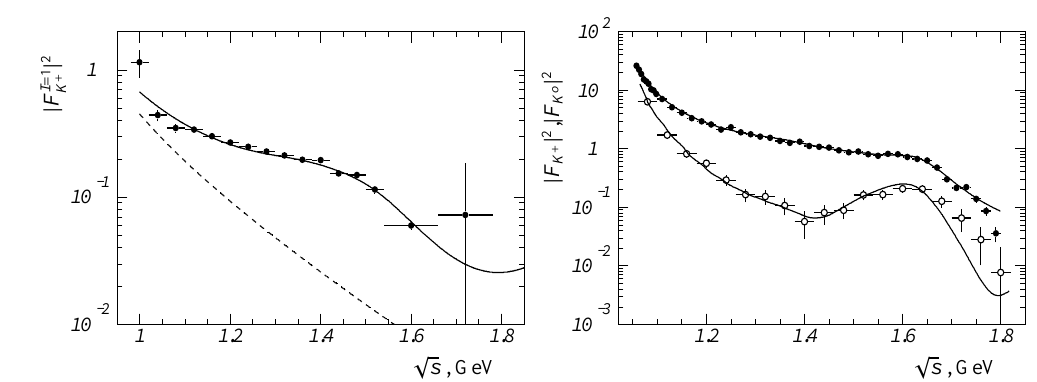
Figure 1. Left panel: The isovector kaon form factor squared obtained from the τ − ential decay rate [8] as a function of √ s . Right panel: The charged (open circles) and neutral (filled circles) kaon form factors squared obtained from the e + e − section data respectively. In the both panels, the solid curves represent the results of the fit (Model II) described in the text. The dashed curve in the left panel shows the ρ (770)